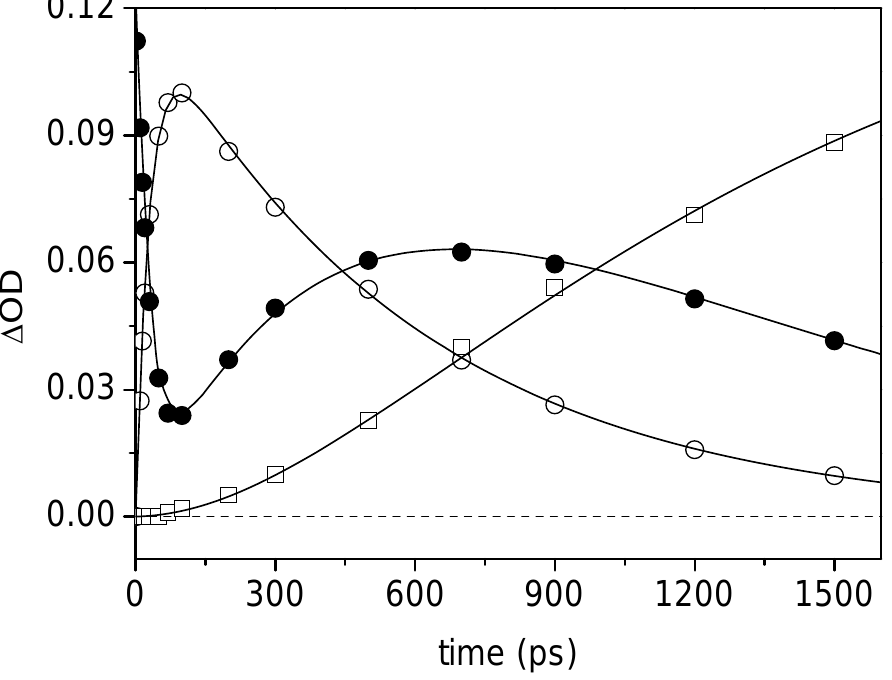
Figure 2. Time dependence of the extracted contributions of the T 339 nm ( ο ), N-hydro radical absorption at 365 nm ( □ ), and residual absorption (S anion radical) at 381 nm ( ● ) and best fit (solid lines) obtained from the spectra in Figure